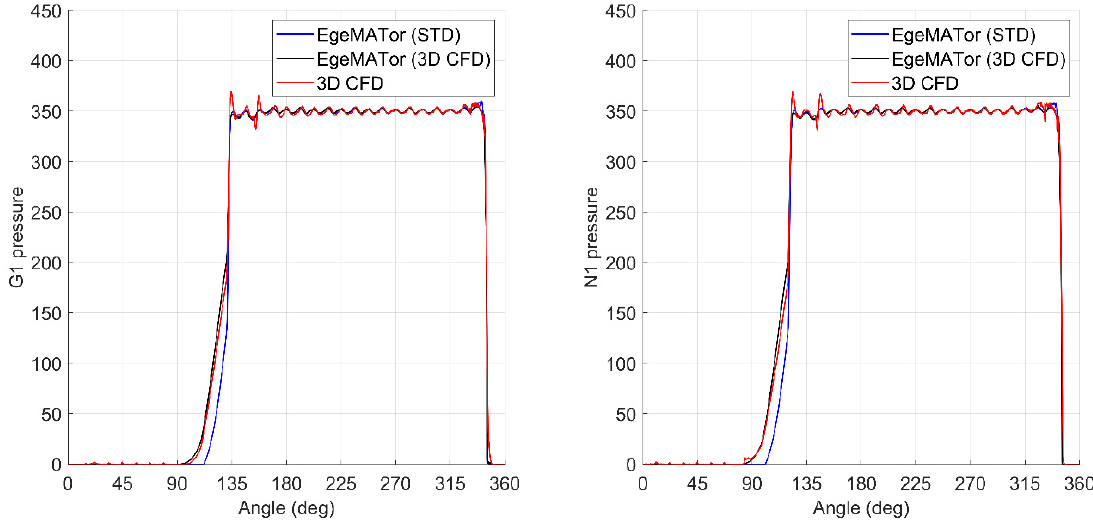
Figure 11. Gi and Ni pressure distributions.